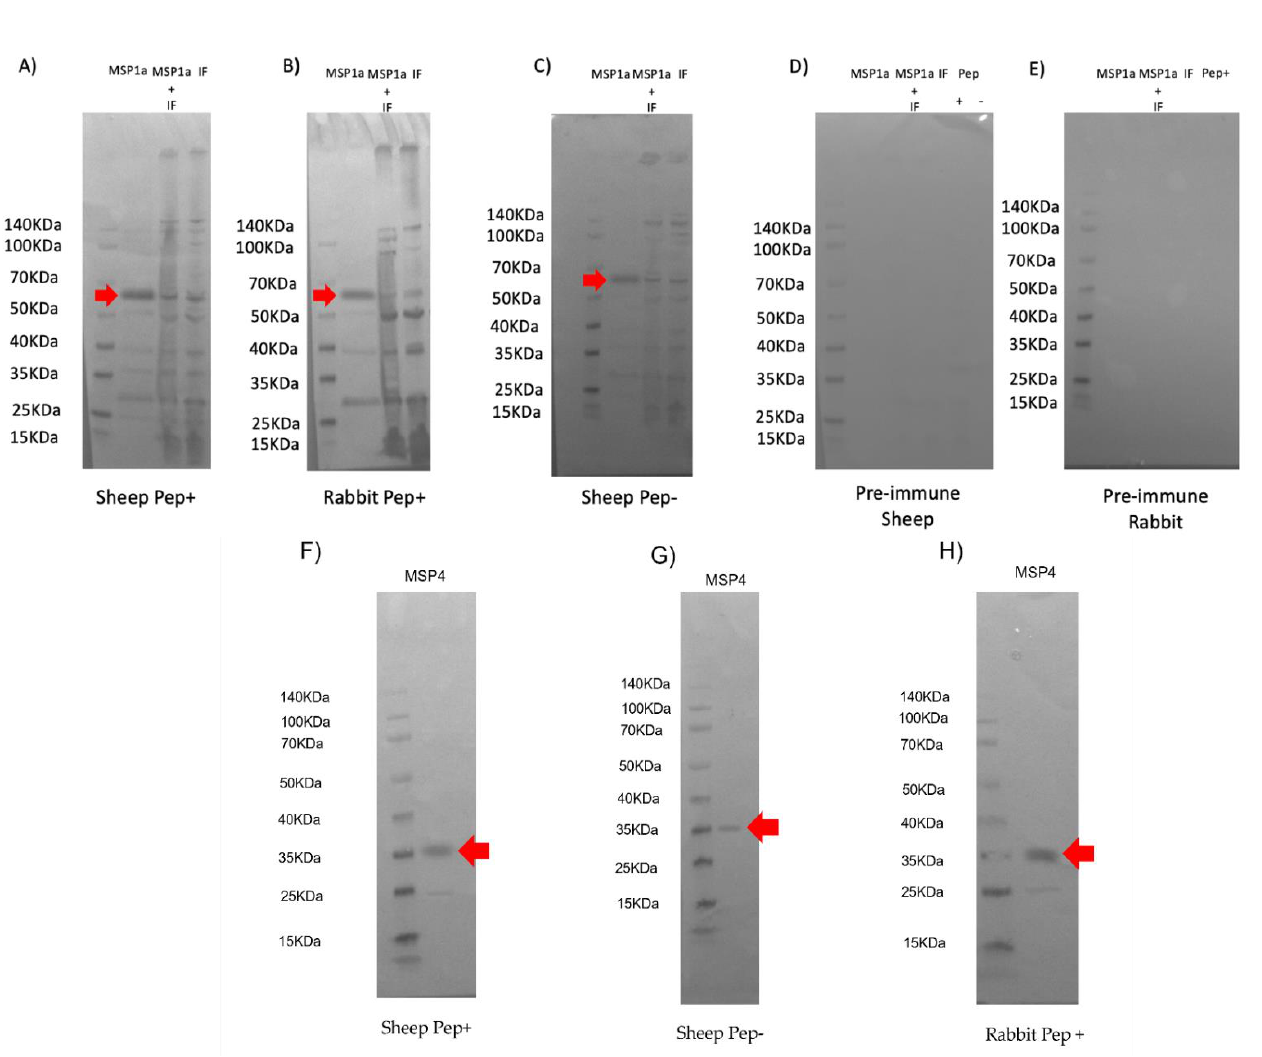
Figure 3. Antibody detection of the protein components included in the chimeric protein formulation by IgG antibodies produced in sheep and rabbit previously immunized with MSP1a and the chimeric protein exposed in the E. coli membrane. Samples equivalent to 10 µg of the total proteins: recombinant purified MSP1a (MSP1a), MSP1a expressed as an exposed antigen mixed with the insoluble E. coli fraction (MSP1a + IF), the insoluble E. coli fraction alone and recombinant purified MSP4 were loaded on a 12% polyacrylamide gel and for Western blot analysis, proteins were transferred to a nitrocellulose membrane as was explained above. ( A ) A Western blot was performed using IgG antibodies from sheep immunized with recombinant peptide+ (pep+) where MSP1a was detected showing a molecular weight of 67 kDa, as expected, and proteins from the insoluble fraction were also detected. ( B ) The same protein samples were also detected but using IgG antibodies from rabbit immunized with recombinant peptide+ and ( C ) sheep immunized with recombinant peptide-. ( D ) A Western blot using pre-immune serum samples from sheep and ( E ) rabbit were also used with the protein samples showing no specific signal. Red arrows denote the position of the antigen MSP1a. Spectra (Thermo Fisher Scientific) was used as molecular weight markers for protein electrophoresis, ( F ) recognition of recombinant MSP4 protein at the expected molecular weight of 35 KDa by IgG antibodies from sheep immunized with peptide+, ( G ) with peptide- and ( H ) IgG antibodies from rabbits immunized with